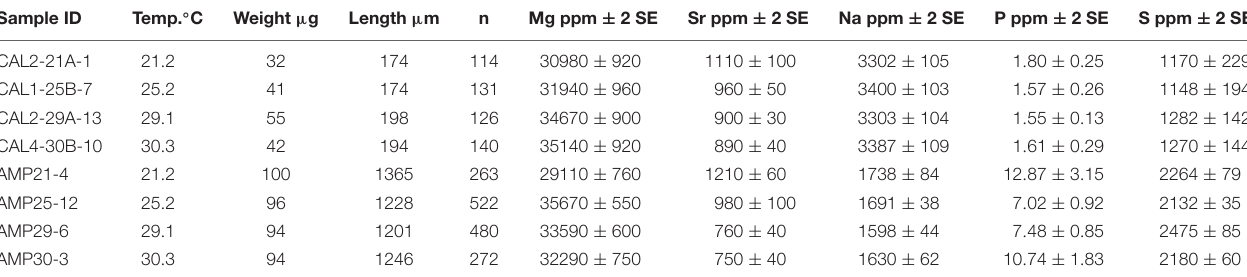
TABLE 1 | Element concentrations in cultured